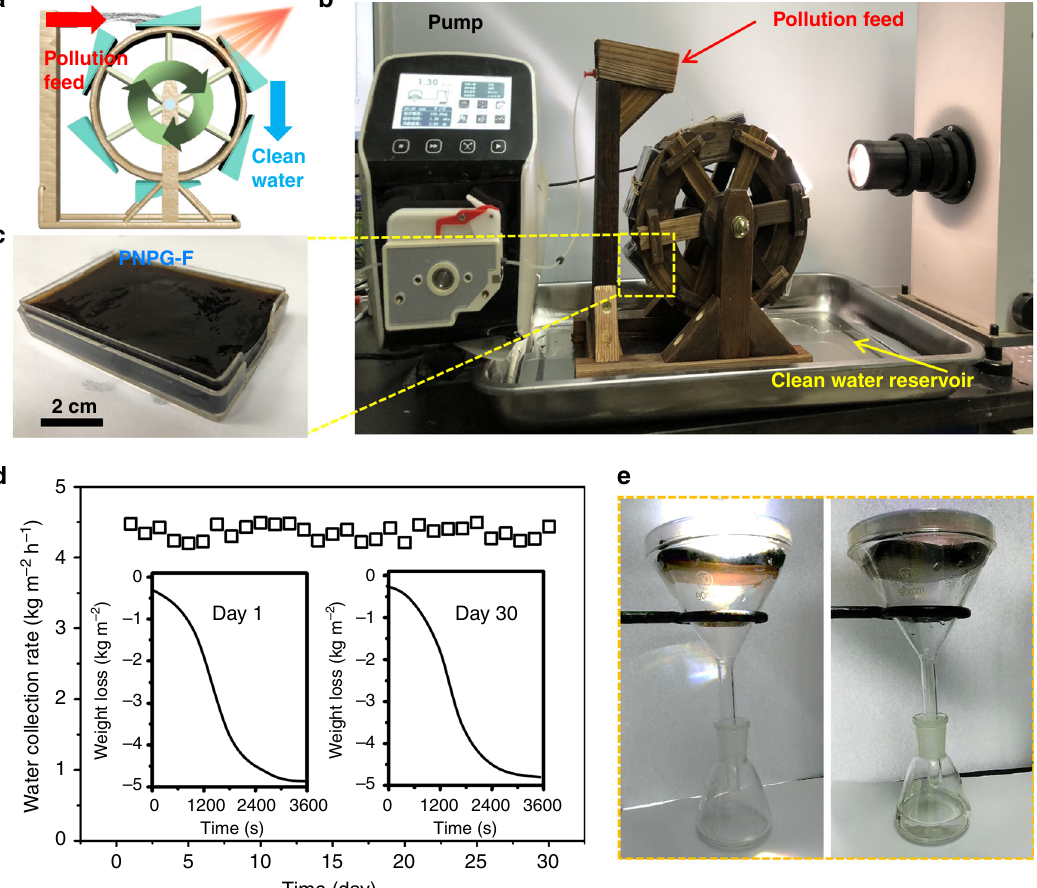
Fig. 6 Continuous water puri fi cation using PNPG-F. a Schematic of a water collector based on a waterwheel structure. b The PNPG-F puri fi er is fi xed on the gear of the waterwheel. Polluted water is fed by a pump. As the waterwheel rotates at a speed of 1 revolution every 10 min, clean water is continuously collected under solar irradiation. c A digital image of a single PNPG-F. d Water collection rate of the PNPG-F puri fi er immersed in seawater for 30 days. The results of the collection demonstrate the durability of the PNPG-F puri fi er. Insets are the typical water collection behavior on exposure to seawater for 1 and 30 days. e A simple device for the whole collection of water from transpiration and